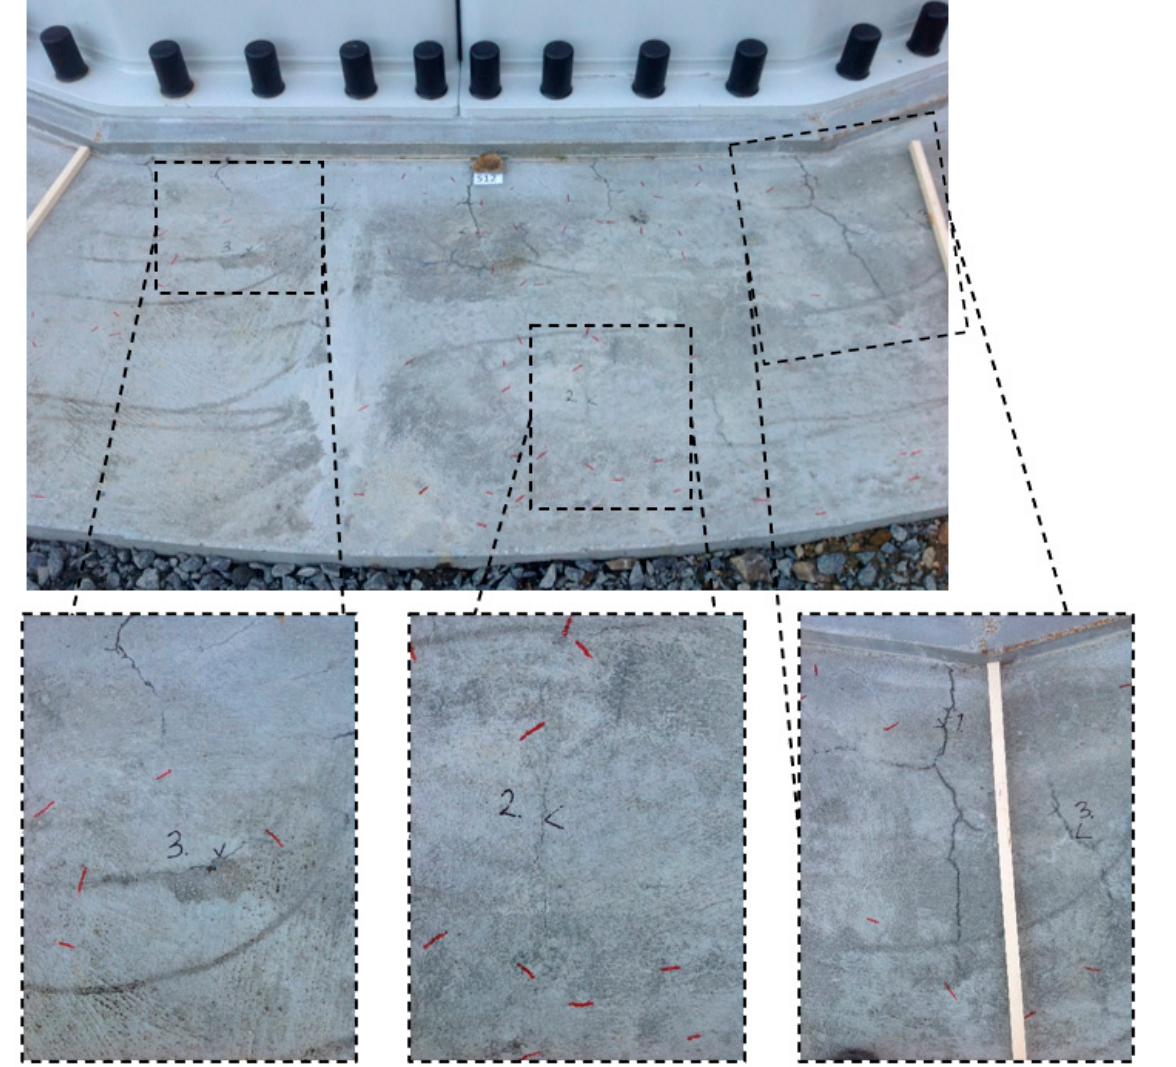
Figure 6. Cracks on the horizontal pedestal surface, including three zooms of selected areas, with red marks indicating the ends of the cracks and labels 1, 2, and 3 indicating arbitrary labelling of cracks on site.